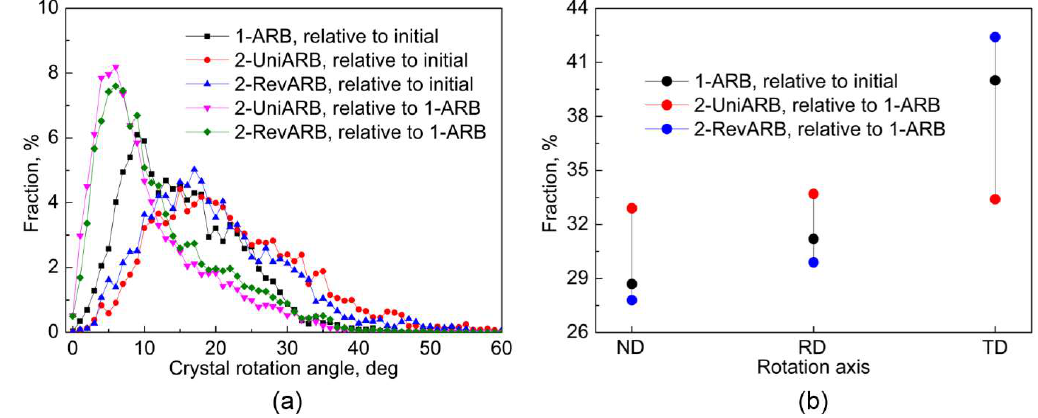
Figure 4 . ( a ) Distribution of crystal rotation angles, and ( b ) fraction of RD-, ND-, and TD-axis. Texture evolution is a pronounced function of the starting texture and imposed deformation[3].